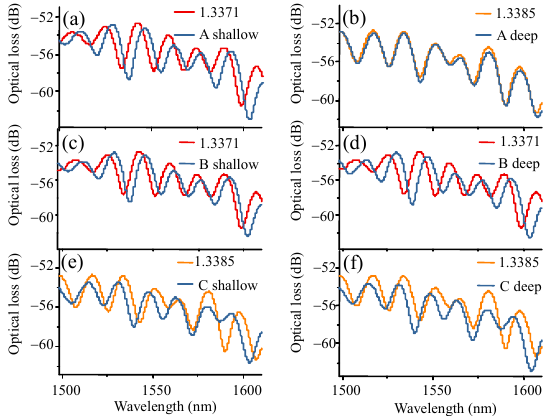
Fig. 11 Comparison of seawater samples with the standard spectrum: (a) comparison of “A shallow” sample and n =1.3371, (b) comparison of “A deep” sample and n =1.3385,